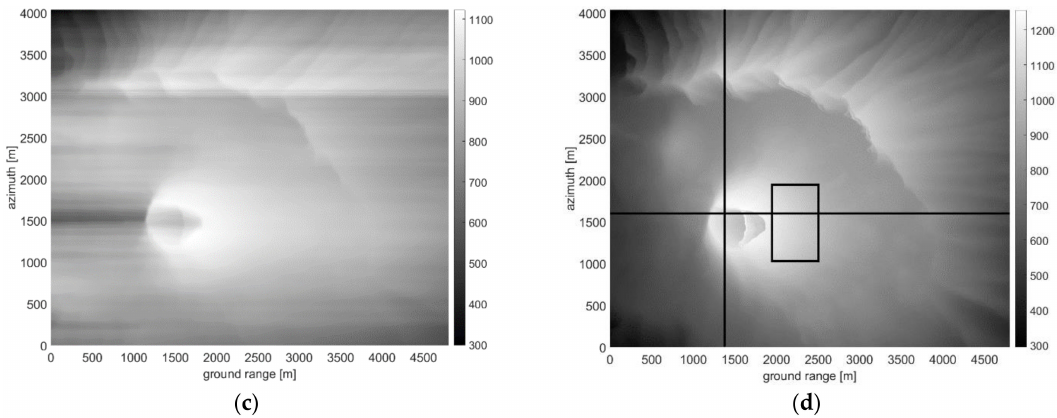
Figure 20. DEM estimated from multilook image ( a ) before and ( b ) after azimuth regularization procedure. ( c ) DEM estimated from multilook-image assuming knowledge of the mid-azimuth line. ( d ) 5m-resolution ground-truth DEM obtained via an aero-photogrammetric technique in azimuth-slant range coordinates. Black lines identify range and azimuth cuts reported in the following figures. The black box indicates the region selected for volumetric scattering contribution estimation.